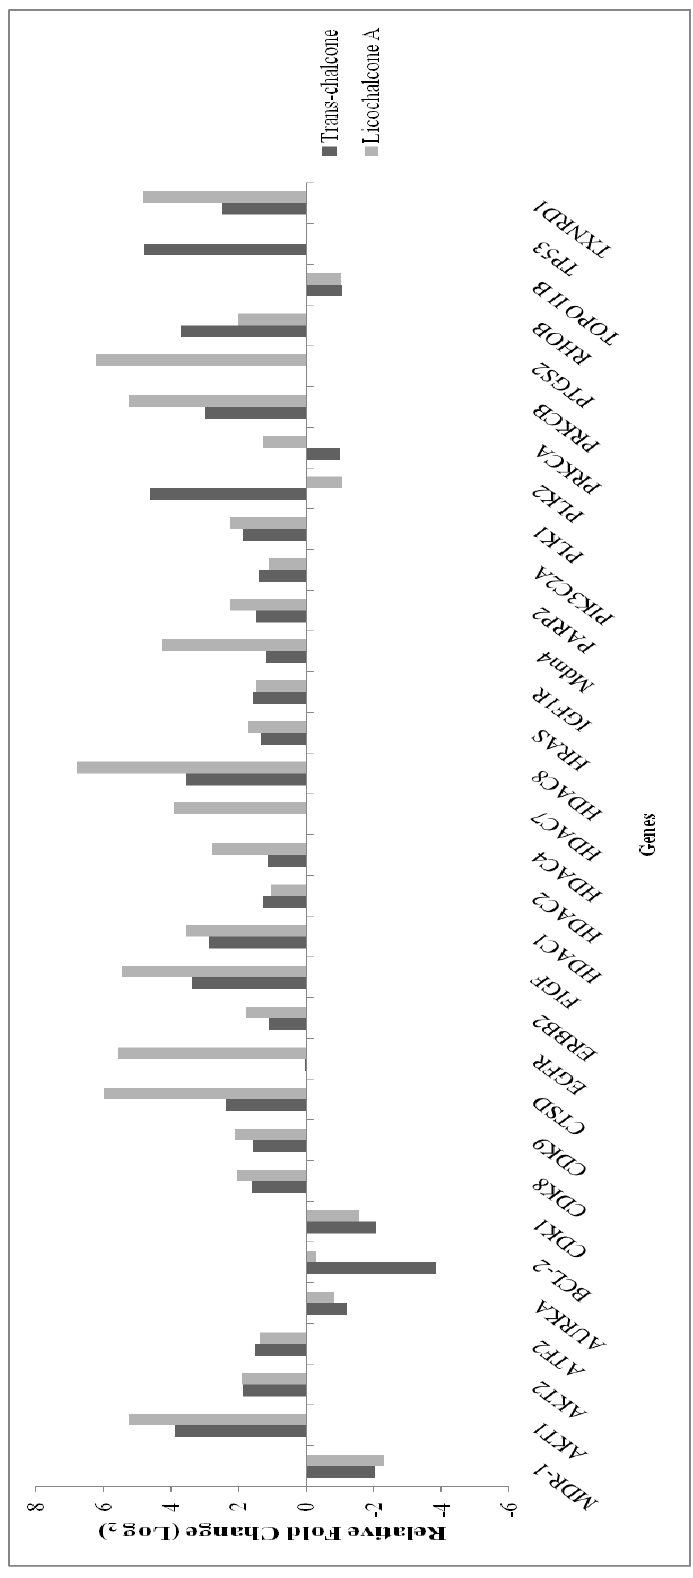
Figure 2. Profile of gene expression by PCR array for MCF-7 cell line.